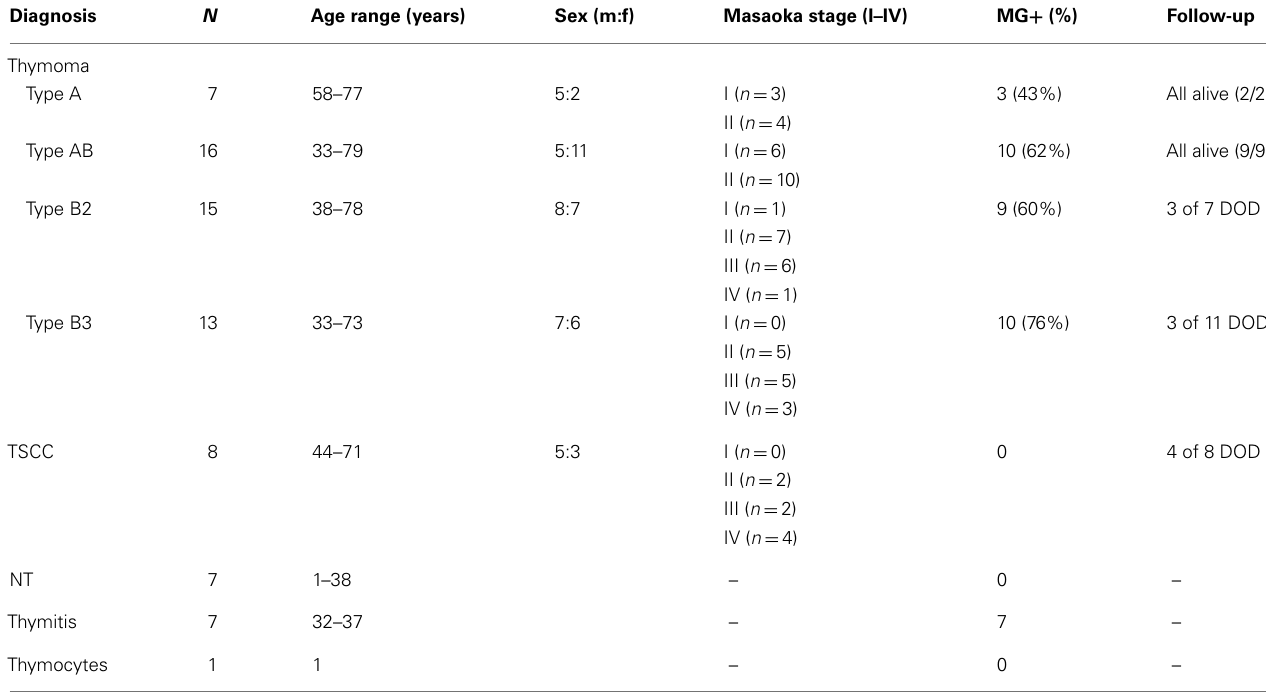
Table 1 | Characteristics of patients and tissues:WHO typeA,AB, B2, B3 thymomas;TSCC, thymic squamous cell carcinoma; NT, normal thymus; thymitis, non-neoplastic thymus with lymphofollicular hyperplasia (LFH) from early-onset Myasthenia Gravis (MG) patients; thymocytes, purified from NT; MG + (%), %-age of patients with MG.